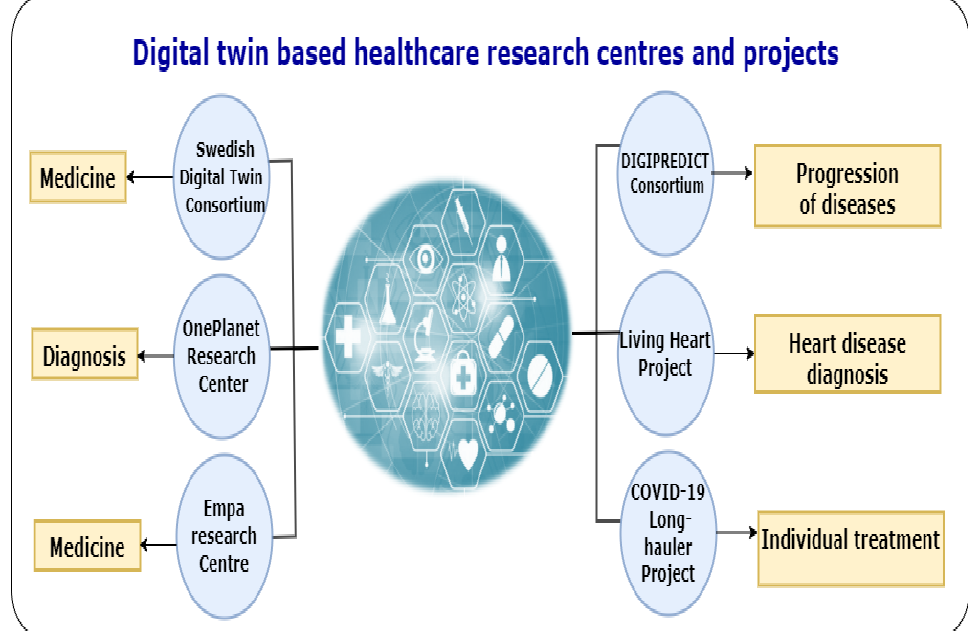
Figure 7. Digital twin-based healthcare research centres and projects and their